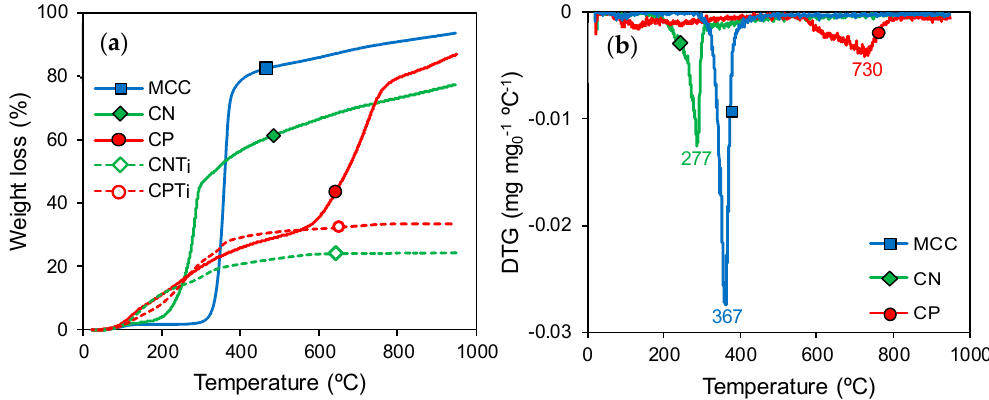
Figure 1. ( a ) Thermogravimetric (TG) profiles under N 2 flow for microcrystalline cellulose (MCC) and acid-treated cellulose samples before (solid lines) and after Ti impregnation (dash lines); ( b ) Differential thermogravimetric (DTG) profiles under N 2 flow for MCC, CN and CP.